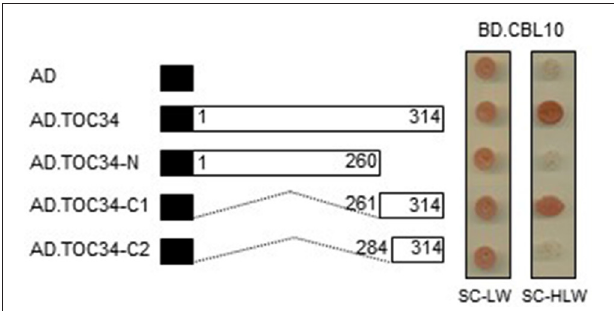
FIGURE 3 | Identification of the TOC34 region responsible for the interaction with CBL10. A full and two deletion constructs of TOC34 were cloned into the pGAD vector and cotransformed into yeast cells with pGBT.CBL10. Yeast growth on the synthetic complete media lacking His, Leu, and Trp (SC-HLW) indicates interaction. Numbers in the white boxes indicate the beginning and the ending positions of each protein fragment. Black boxes denote the activation domain of the GAL4 transcription factor. Numbers indicate the beginning and the ending positions of each protein